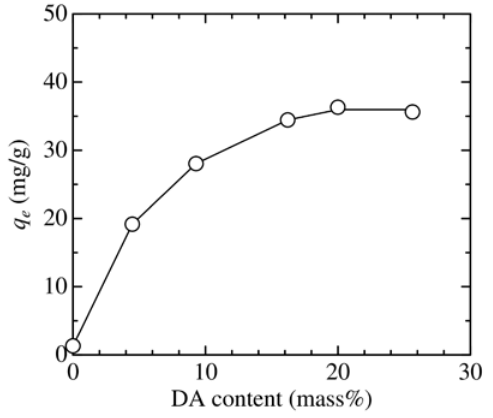
Figure 6. Change in MO equilibrium adsorption capacity of samples with DA content (dosage = 0.5 g/L, initial concentration = 20 mg/L, initial pH = 6.9, temperature = 301 K).